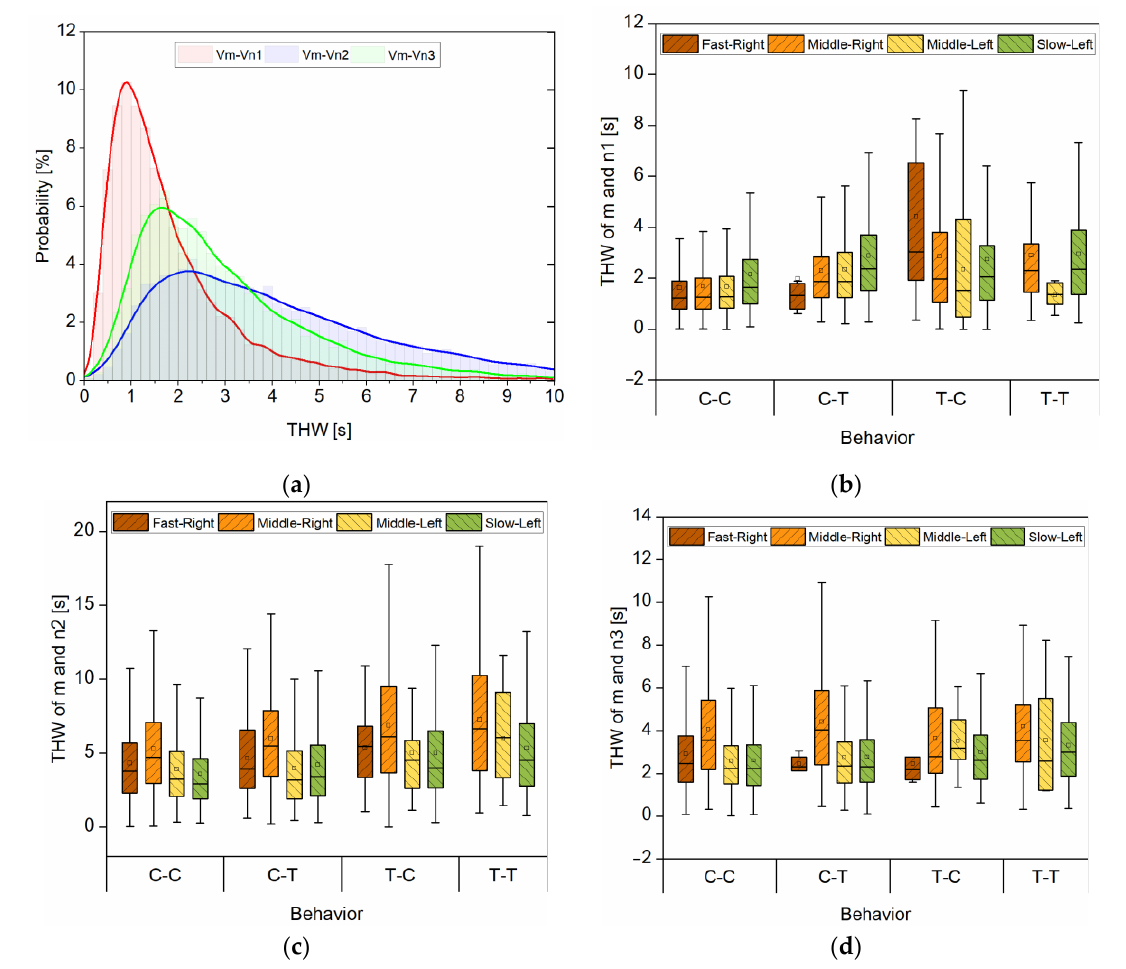
Figure 9. ( a ) Probability distribution of THW; ( b ) THW between m and n1; ( c ) THW between m and n2; ( d ) THW between m and n3.